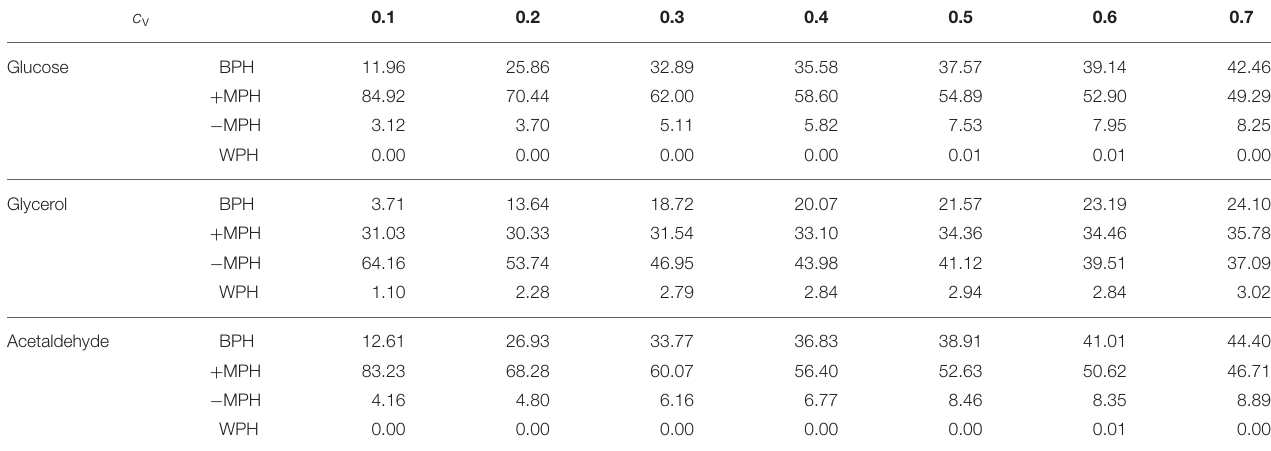
TABLE 2 | Percentage of occurrence of the four types of inheritance for the glucose, glycerol and acetaldehyde fluxes over the range of c v values when E tot is fixed.